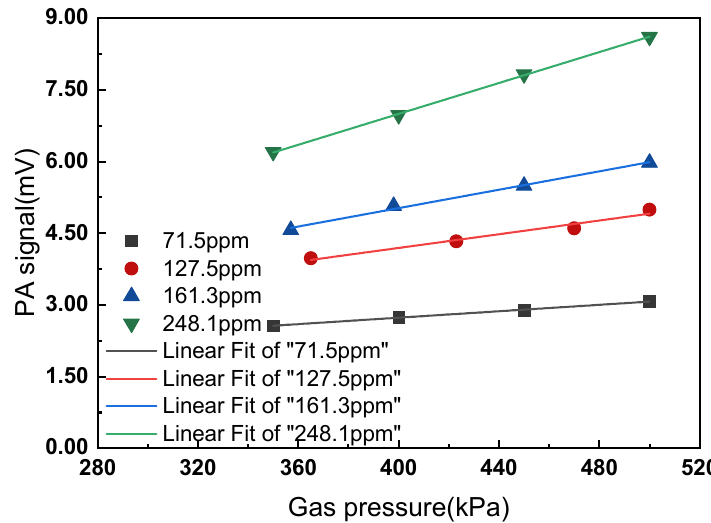
Figure 12. Linear fitting of gas pressure and PA signal.